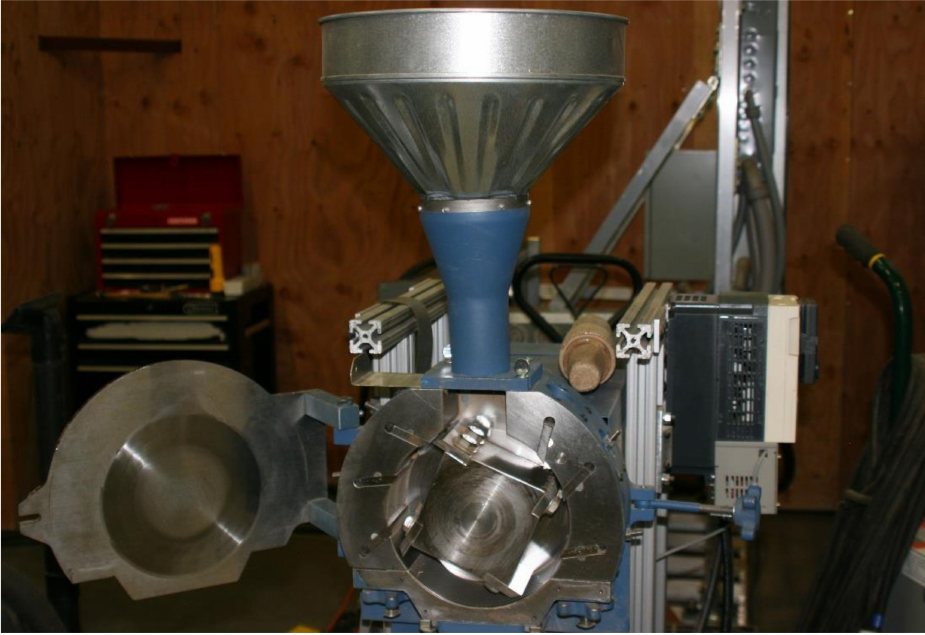
Figure 4. The laboratory scale Wiley mill with blades